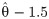
Simulation results for seven Bayesian procedures (Gaussian prior for spreads).Each line corresponds to 1000 simulations for different number of trials for one simulated subject. The parameters of the modelled subject were σS = 1 (i.e.β = 7.327); αS = 1.488 (2AFC) or αS = 1.387 (4AFC); π = 0.75; γS = 0.5 (2AFC) or γS = 0.25 (4AFC); λS = 0.02 (2AFC) or λS = 0.03 (4AFC); δS = 0.012 (2AFC) or δS = 0.018 (4AFC), and threshold of θS = 1.5 log10 arcsec. Left panels show the mean of the threshold bias (θ^−1.5), and right panels show the standard deviation of the distribution of the threshold bias. For all procedures, for the prior probability distribution of spreads, we have assumed a Gaussian distribution with mean and standard deviation obtained from the data shown in Fig 4A (2AFC_g; mean = 1.005, SD = 0.776) and Fig 4B (4AFC_g; mean = 1.186, SD = 0.740). Note that the y-values for Threshold bias are different for 2AFC and 4AFC tasks.